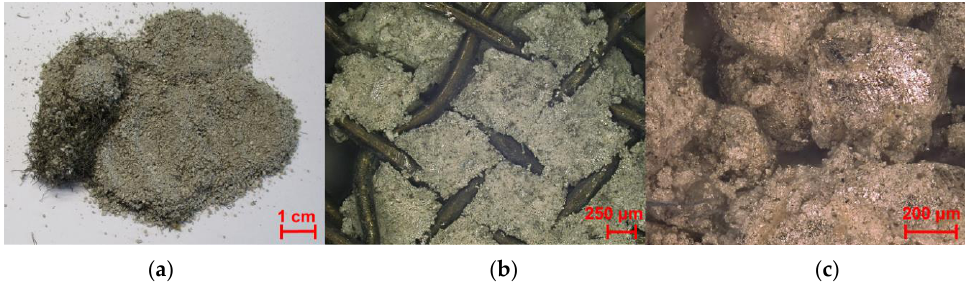
Figure 2. Samples after cryogenic treatment. ( a ) Macroscopic image, ( b ) microscopic image of the